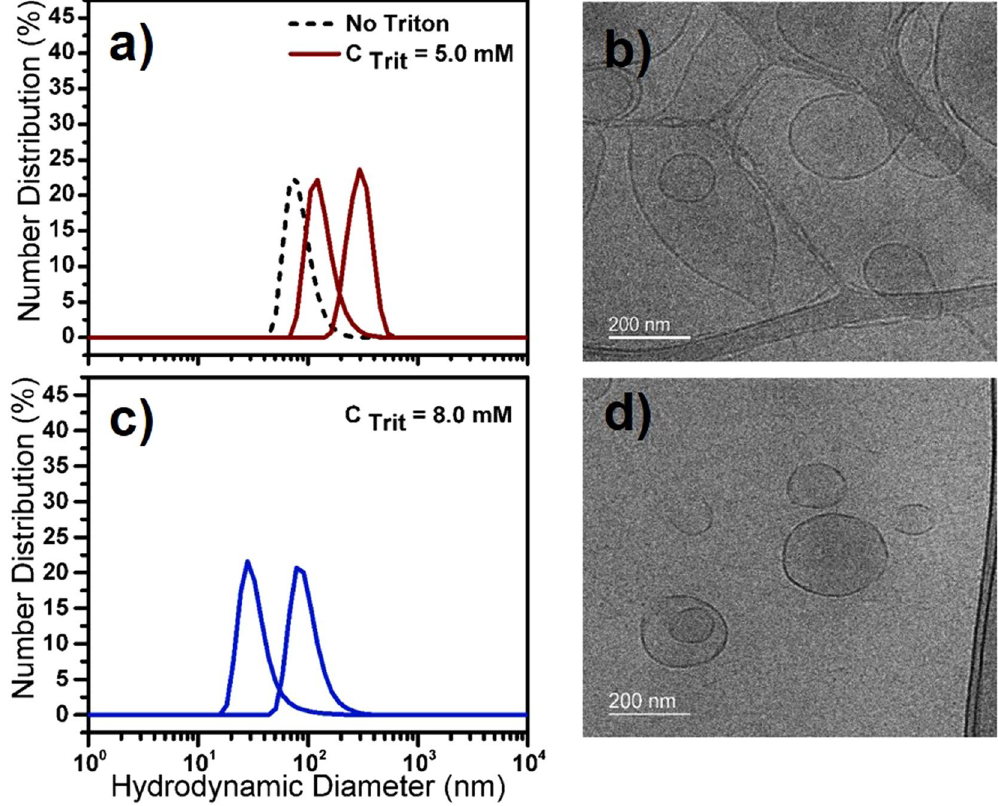
Figure 3. Number distribution (%) from DLS measurements ( a , c ) and corresponding cryo-TEM micrographs ( b , d ) of preformed DPhPG liposomes during the second stage (stage II) of solubilization with TX-100. Liposomes were treated with different TX-100 concentrations of ( a , b ) C Trit = 5.0 mM, and ( c , d ) C Trit = 8.0